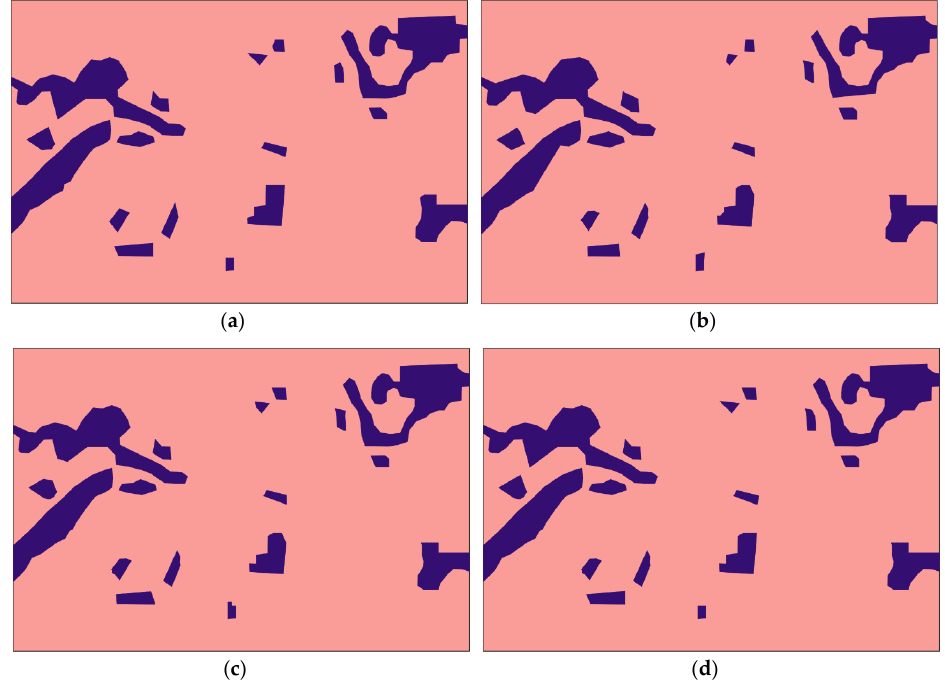
Figure 5. Effects of contourlet subbands for Pune image: ( a ) reference; ( b ) U-cnet_1; ( c ) U-cnet_2; ( d ) U-cnet_3.